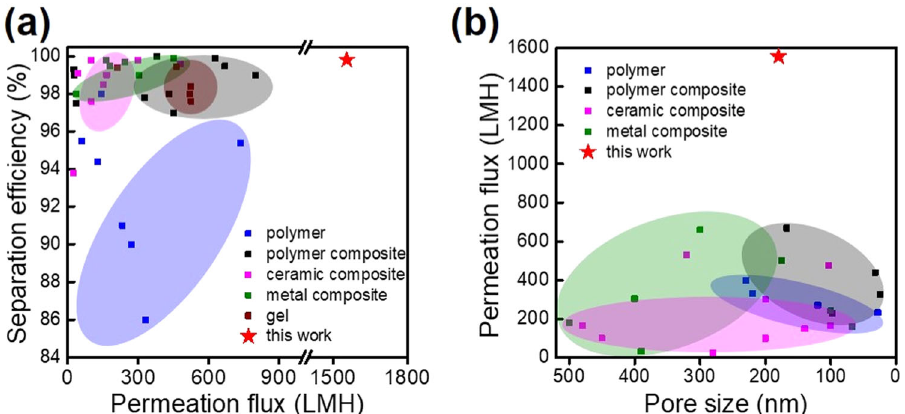
Fig. 9 Outperforming by two-fold all membranes. Performance comparison of a separation ef fi ciency, permeation fl ux, and b pore size of our coated MCE C relative to other membranes developed for oil/water emulsion separation.